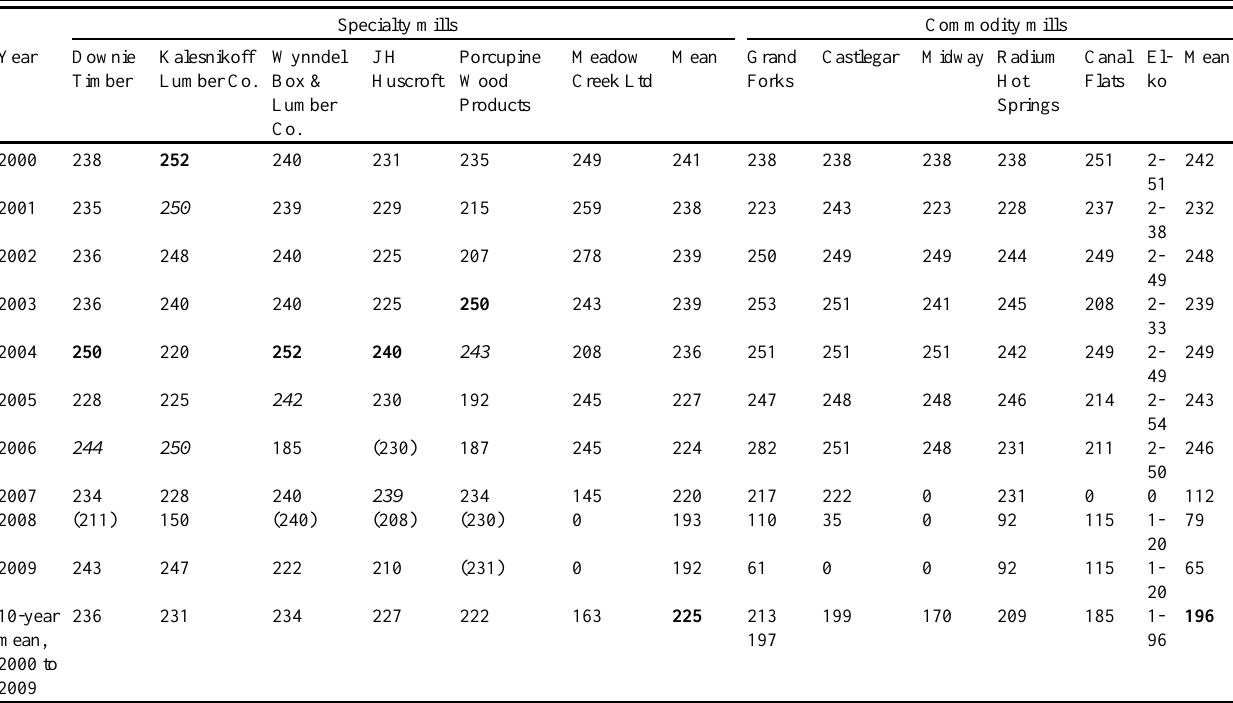
Table 2 . Days per year of operation, specialty and commodity sawmills in the Columbia-Kootenay Region, 2000 to 2009 ( personal communication , Sinclair Tedder, senior economist, Competitiveness and Innovation Branch, British Columbia Ministry of Forests and